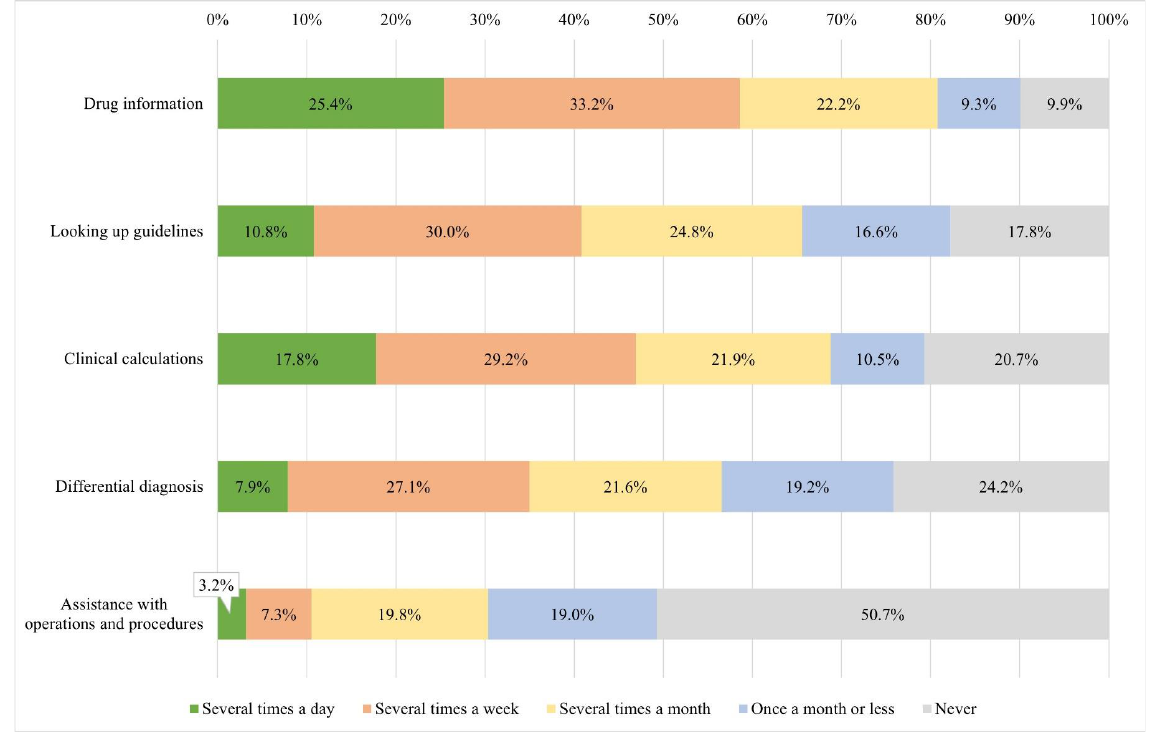
Figure A5. Diagnostic and Therapeutic Decision Support. Int. J. Environ. Res. Public Health 2022 , 19 , x FOR PEER REVIEW